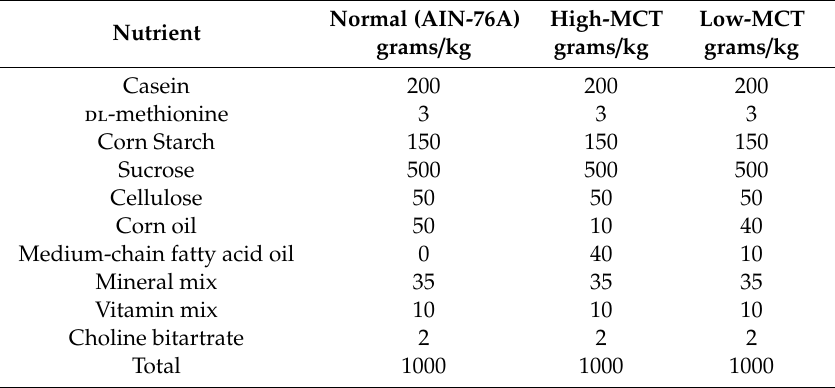
Table 1. Custom diet